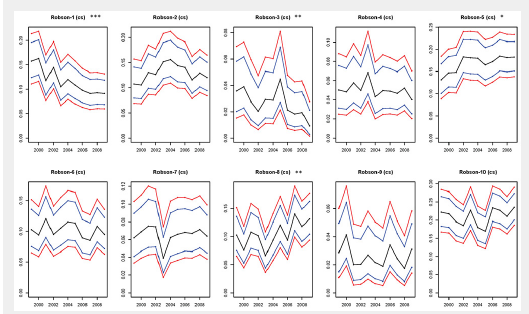
Temporal change within each Robson group in births delivered by caesarean section. Relative size is presented in the observation period of time. Blue lines are 95% confidence limits and red lines are simultaneous 95% confidence limits. The relative size of Groups 1 and 3 decreased significantly and the relative size of Groups 5 and 8 was